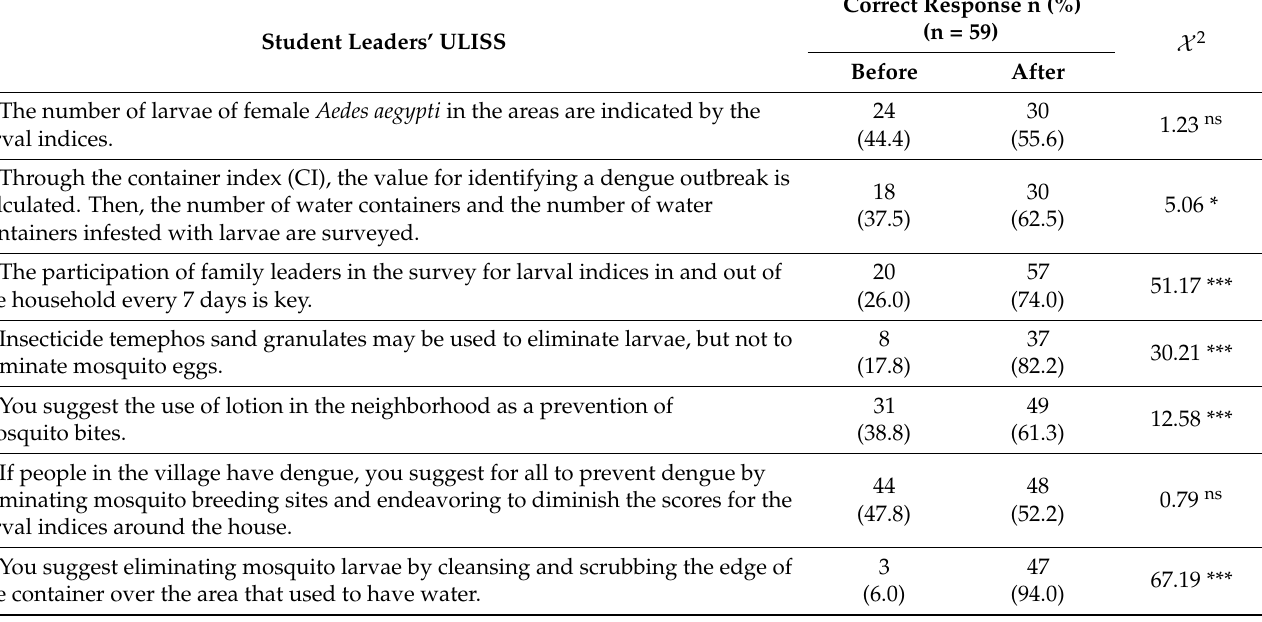
Table 9. Comparison of correct response rates regarding the ULISS of student leaders before and after implementation of the training